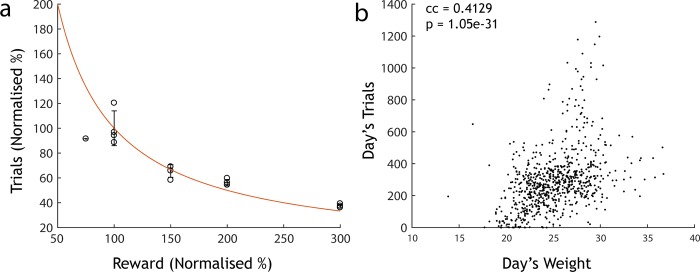
Mice are motivated but not water restricted.(a) Number of trials performed normalised to mean of trials performed across animals at 100% reward vs. the amount of reward delivered on each correct trial (n = 4 mice, 100% reward = 12μl). Mice perform fewer trials with larger reward volumes (roughly according to the red line of constant daily water intake (red: trials x reward = const line)). (b) Number of trials per vs. recorded day’s weight in a separate cohort (n = 20). There is a strong positive correlation between weight and number of trials performed, suggesting that animals are capable of regulating their own metabolic demands within AutonoMouse.